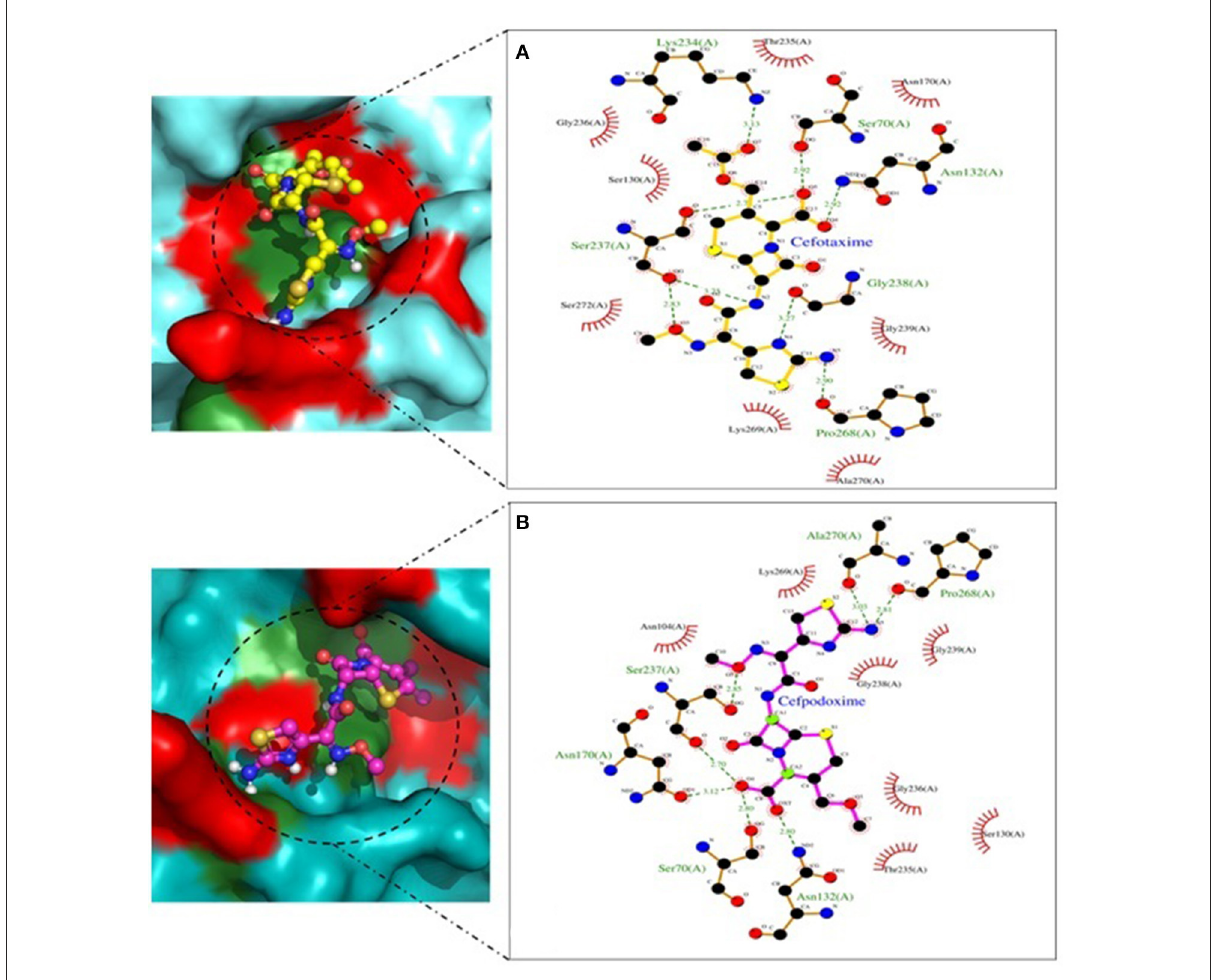
FIGURE6 CTX-M-15 involved in interactions. (A) A binding map for cefotaxime + CTX-M-15. (B) A binding map for cefpodoxime + CTX-M-15.